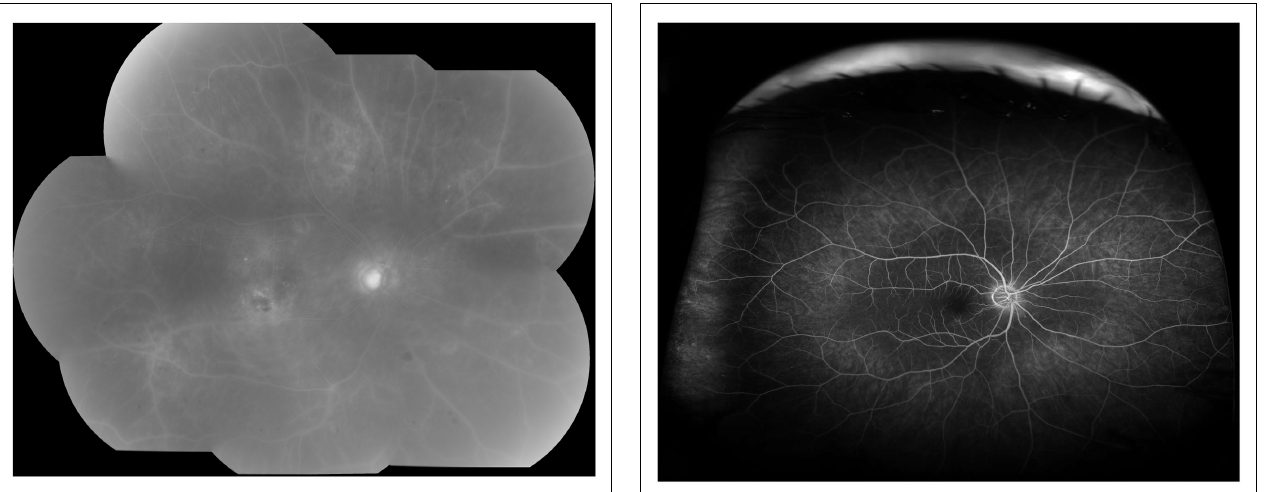
FIGURE 4 |Wide-angle fluorescein angiography obtained with the Optos imaging system . Note excellent visualization of the vascular tree in the posterior pole and midperipheral retina with a single short.